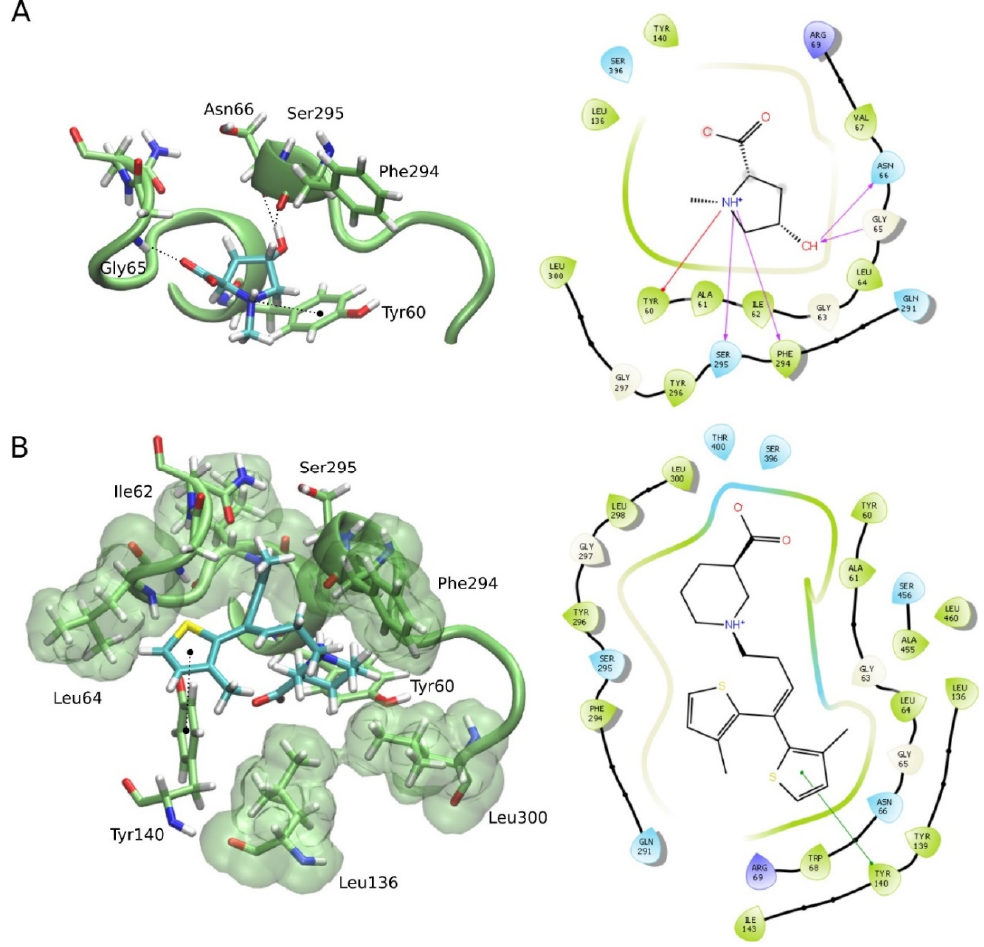
Figure 6. Predicted binding mode for the N -methyl-(2S,4R)-trans-4-hydroxy- L -proline-rich fraction (NMP) and the tiagabine molecule, into the GAT1 binding site. ( A ) Intermolecular 3D and 2D interactions of NMP with the main GAT1 model obtained by docking in the 3D representation; H-bonds are presented as black dashed lines and the hydrophobic interactions as green surfaces. In the 2D interaction diagram, hydrogen bonds are presented as magenta arrows and cation-Pi interaction as red arrows. ( B ) Intermolecular 3D and 2D interactions of tiagabine with GAT1: in the 3D representation, the Pi–Pi interaction is presented as black dashed lines and the hydrophobic interactions as a green surface. In the 2D interaction diagram, the Pi–Pi interaction is represented as green arrows.